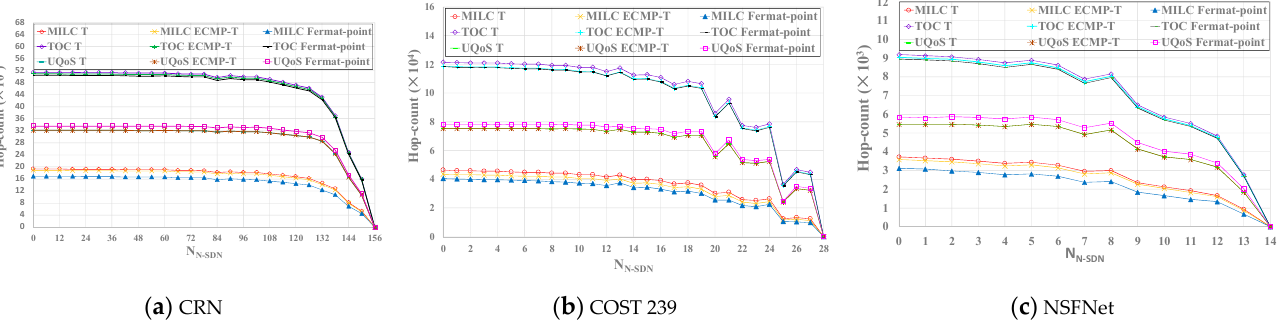
Figure 10. The impact of three SDN interception models on MILC, TOC, UQoS under three topologies. Hop-count. The lower, the